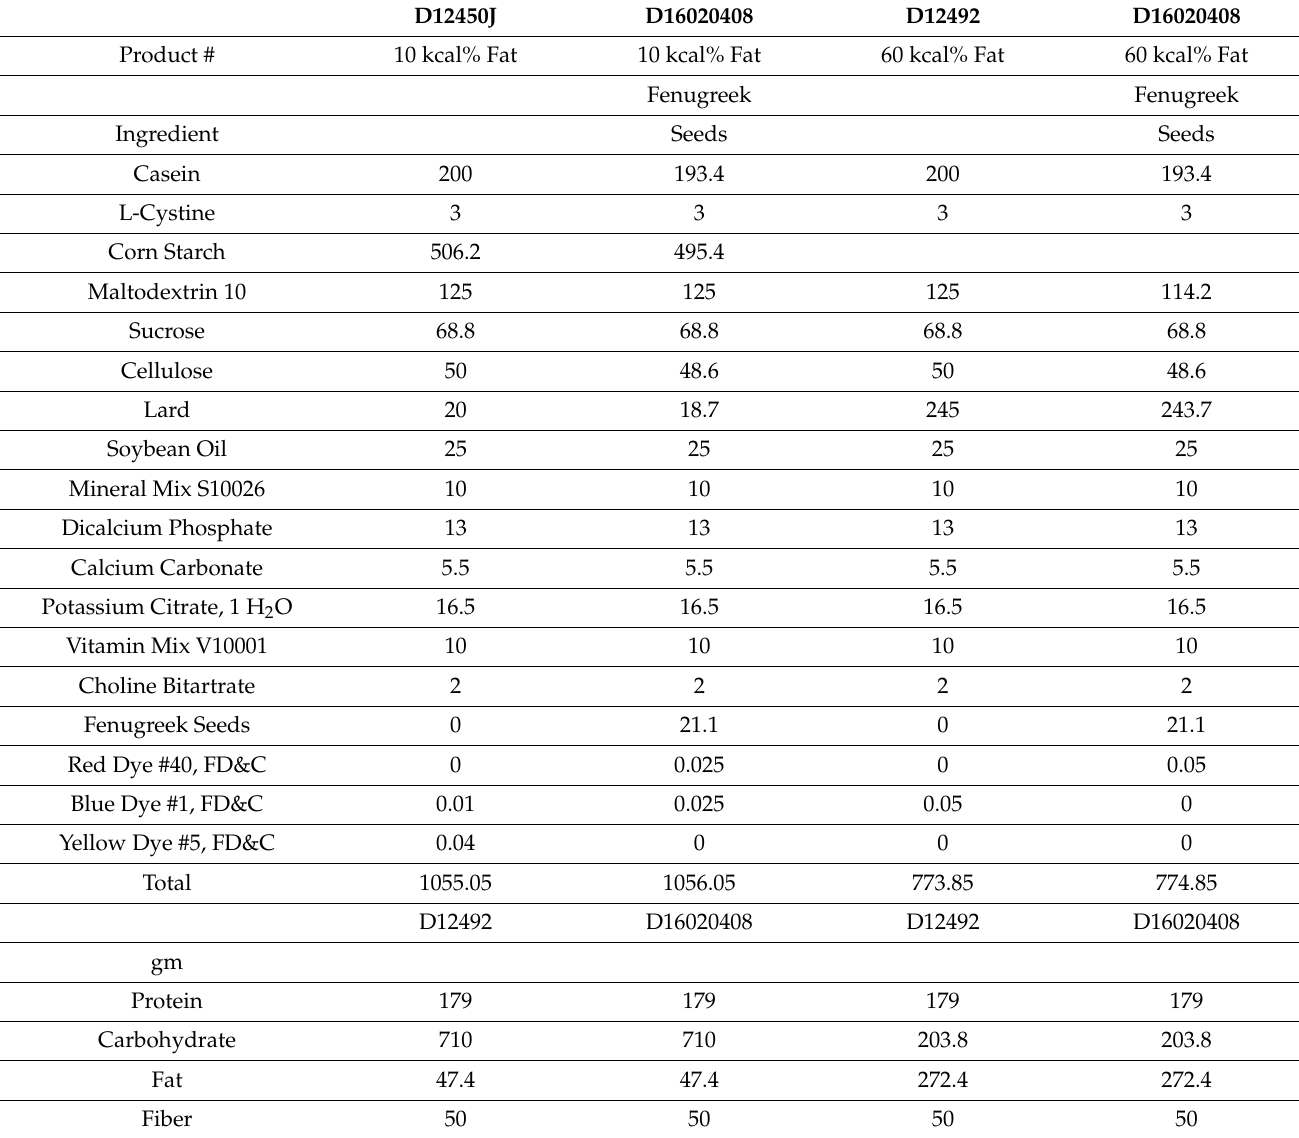
Table A2. D12492 and D16020408 Rodent Diets with 10 or 60 kcal% Fat and Same with